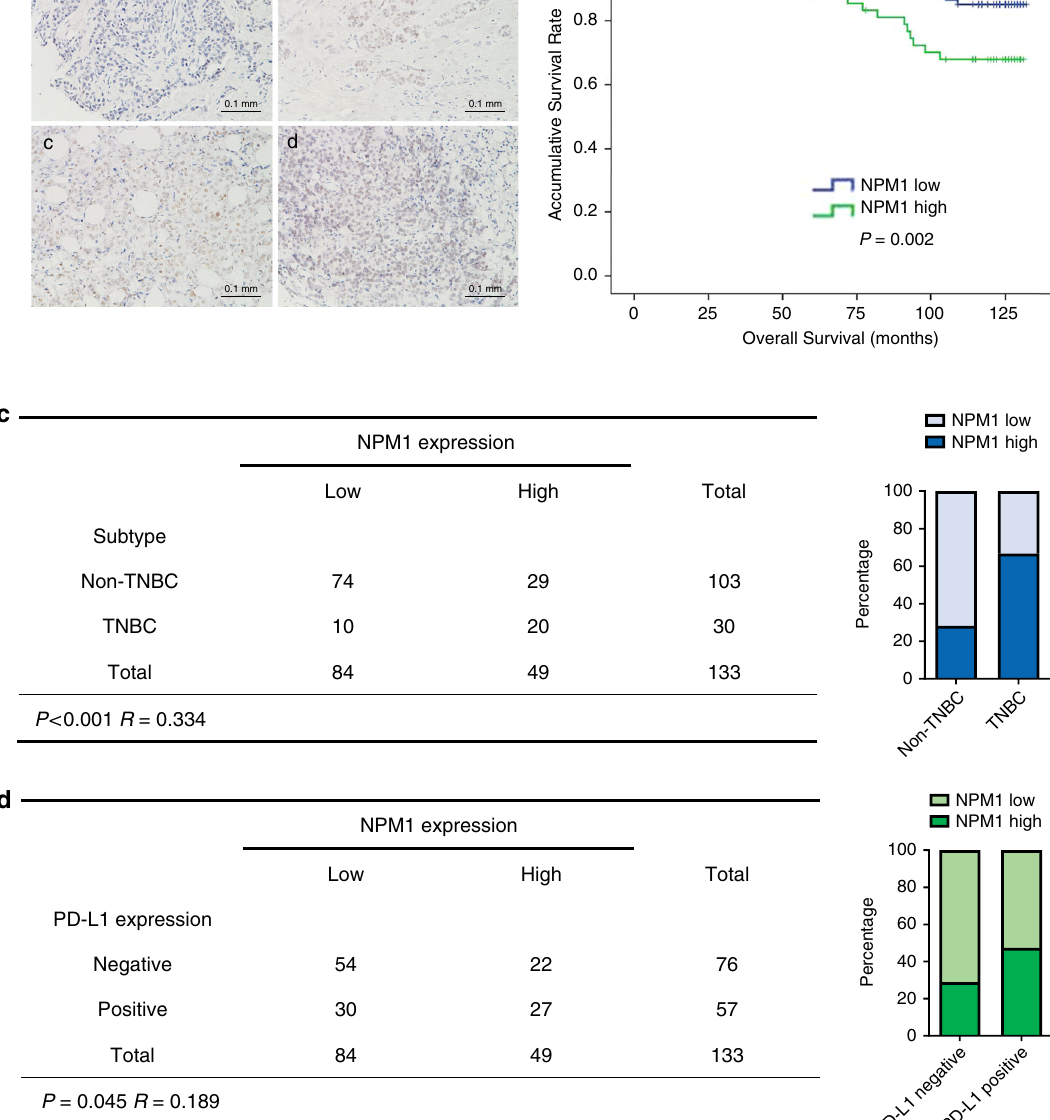
Fig. 4 NPM1 is a poor prognostic factor and correlated with PD-L1 expression in breast cancer. a Representative images of IHC of NPM1 in 133 breast cancer tissues ( a , low expression; b – d high expression). b Kaplan – Meier analysis based on NPM1 expression in 133 breast cancer patients. Data was analyzed by log-rank test. c The correlation analysis between NPM1 expression and TNBC status. d The correlation analysis between NPM1 expression and PD-L1 expression. Two-side Pearson chi-square analysis was used to determine the